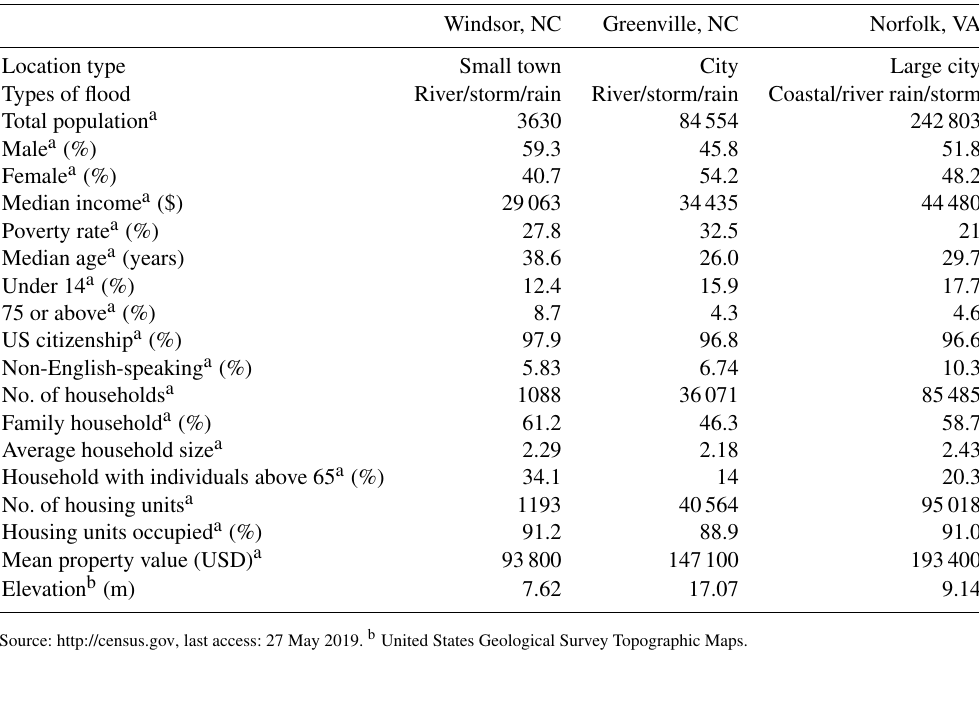
Table 5. Study locations – demographic and topographic summary.